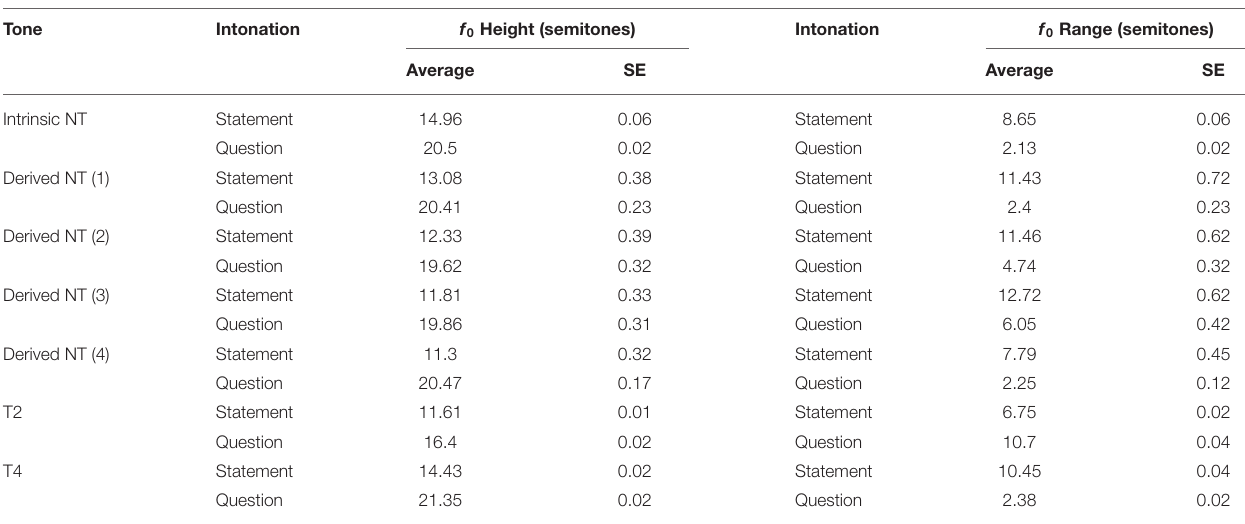
TABLE 2 | Average f 0 height and range of the second